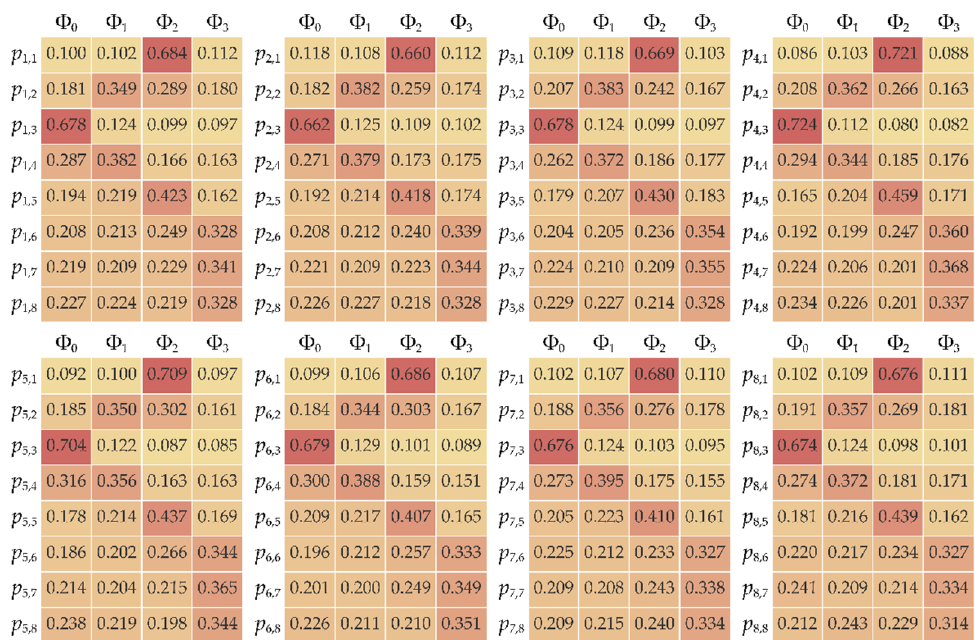
Figure 5. Visualization of meta-path-based attention.